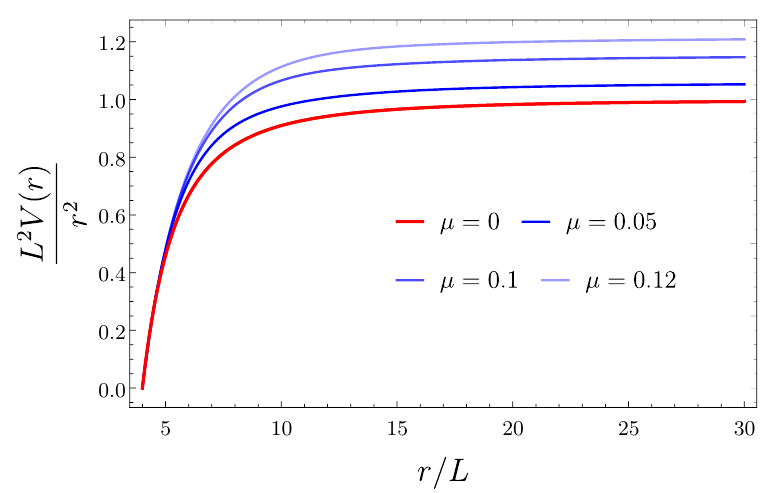
Figure 7 . We plot the metric function V T 2 ( r ) (cid:1) L 2 =r 2 corresponding to Taub-bolt solutions of ECG with n=L = 1 and r b =L = 4 for several values of (cid:22)